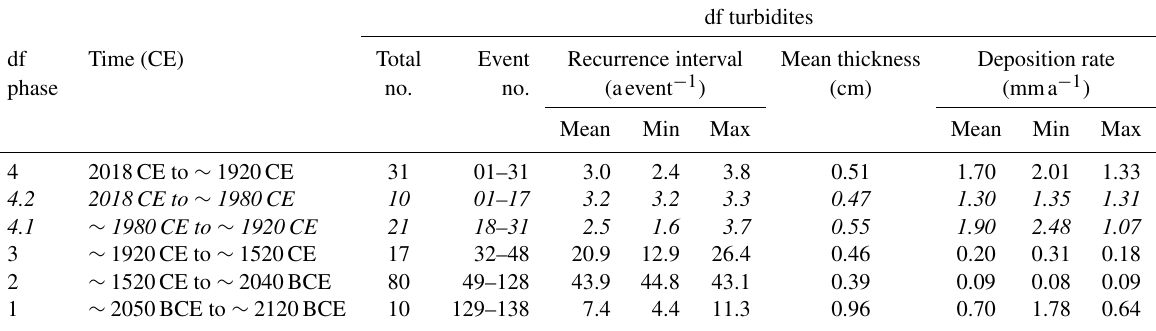
Table 1. Lithostratigraphic phases and corresponding df turbidites including their recurrence interval, mean thickness, and deposition rate. Uncertainties in the recurrence interval and deposition rate are derived from the minimum and maximum ages derived from the age–depth model. Phase 4 is divided into two sub-phases based on frequency changes. These sub-phases 4.1 and 4.2 are shown in italic. df